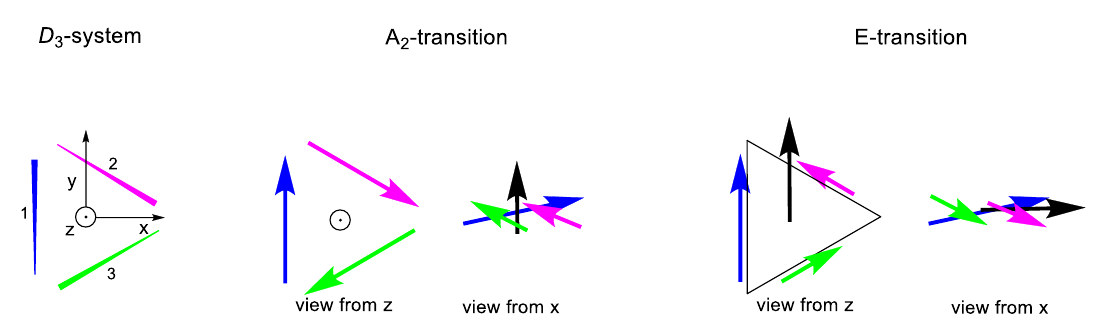
Scheme 5. Representation of a system presenting D 3 symmetry. According to the selection rules, the three equivalent chromophores 1 (blue), 2 (magenta), and 3 (green) can undergo a simultaneous excitation following A 2 or E symmetry, leading to total EDTMs (black) parallel to z or y, respectively, as a result of the summation of the EDTM of each chromophore. A circle with a dot in the middle represents an arrow perpendicular to the plane pointing to the reader.